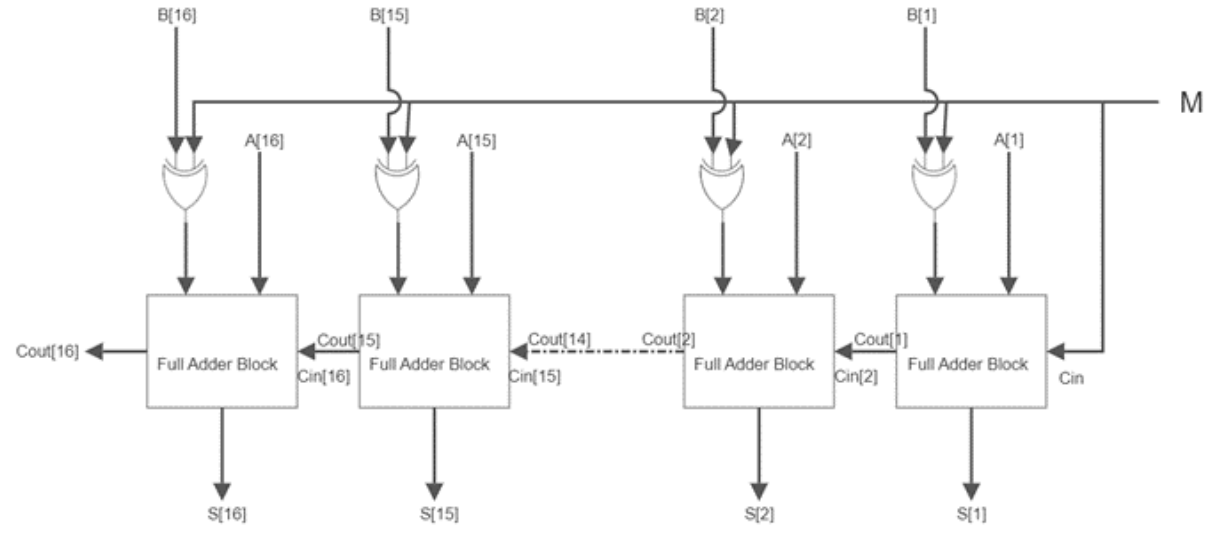
Figure 5. The 16-bit ripple carry full subtractor block